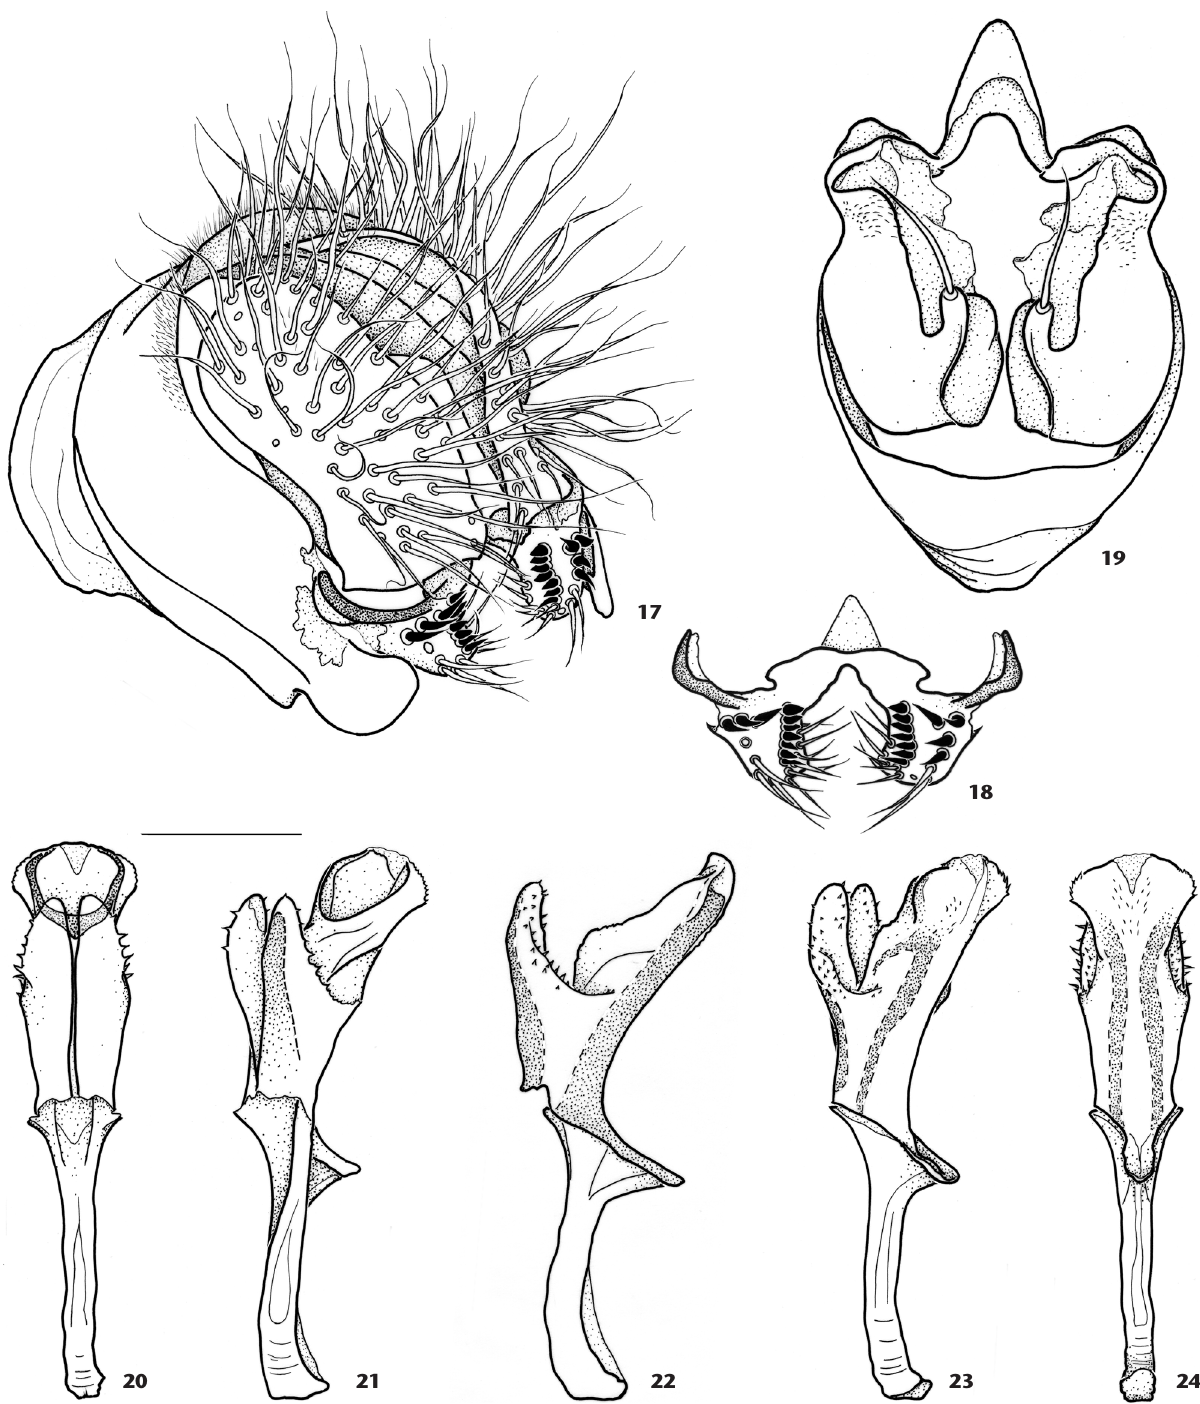
13Figures 17-24. Drosophila montevidensis sp. nov. male holotype, terminalia: (17) epandrium, cerci, surstyli and decasternum, oblique posterior view; (18) surstyli and decasternum, posterior view; (19) hypandrium and gonopods+paraphyses [fused], posterior view; (20- 24) aedeagus+aedeagal apodeme in several views from dorsal through ventral. Scale bar: 0.1 ZOOLOGIA 33(6): e20160142 | DOI: 10.1590/S1984-4689zool-20160142 | December 15, 2016 5 /